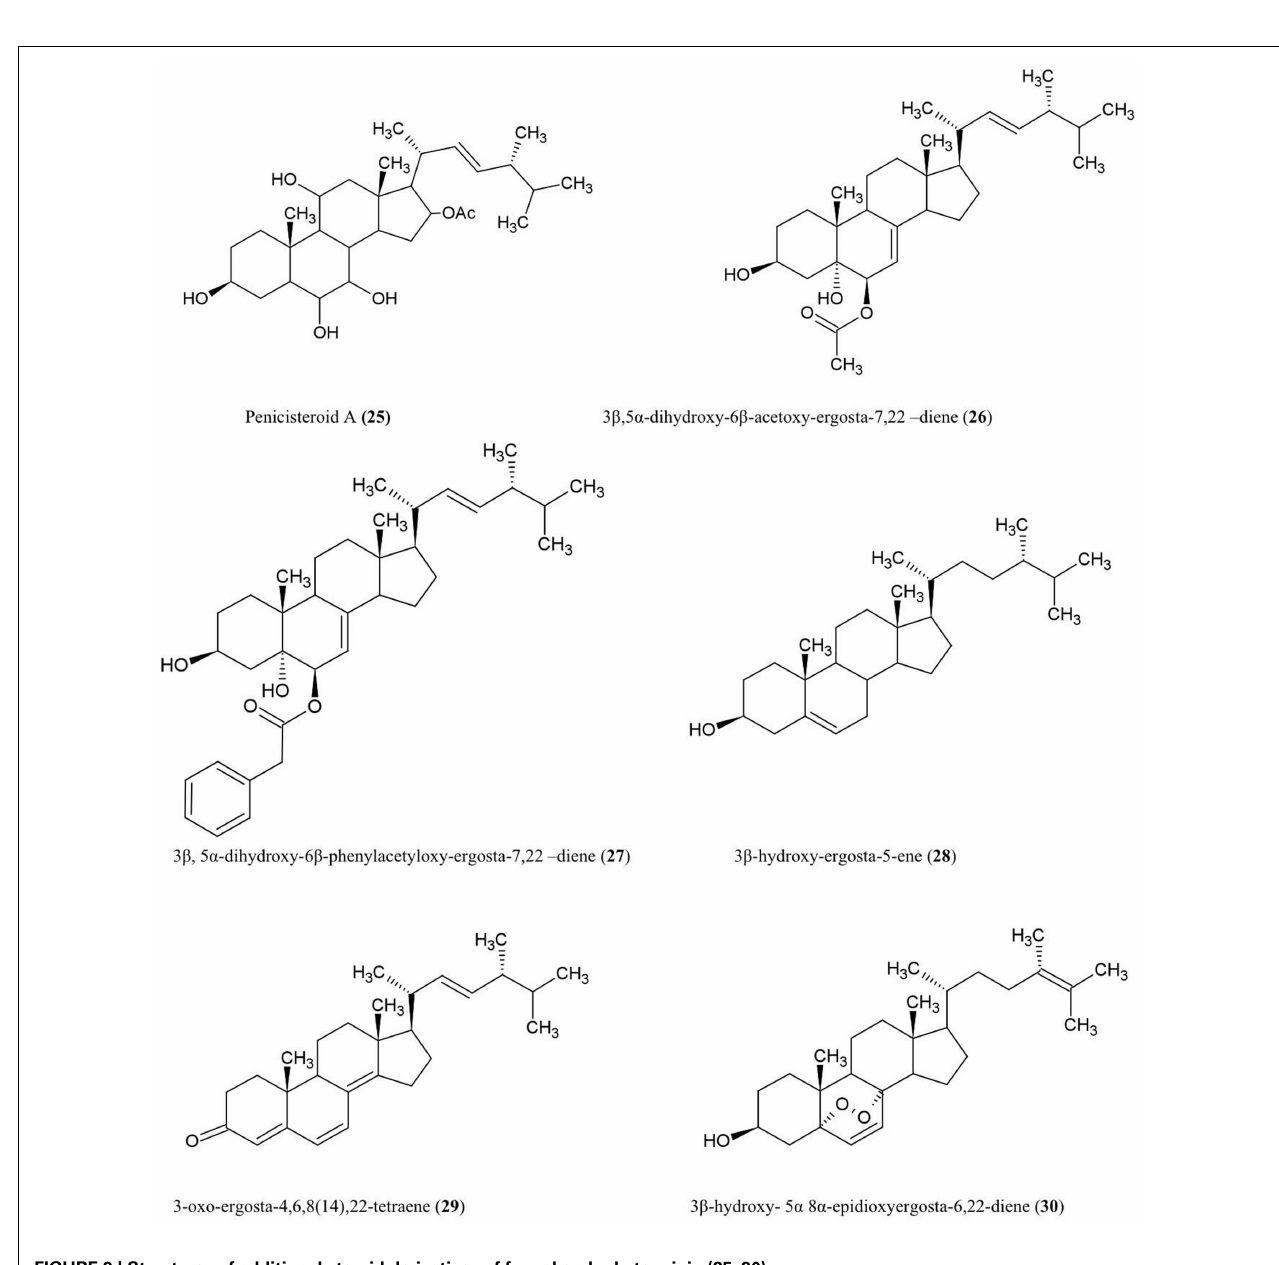
FIGURE 3 | Structures of additional steroid derivatives of fungal endophyte origin